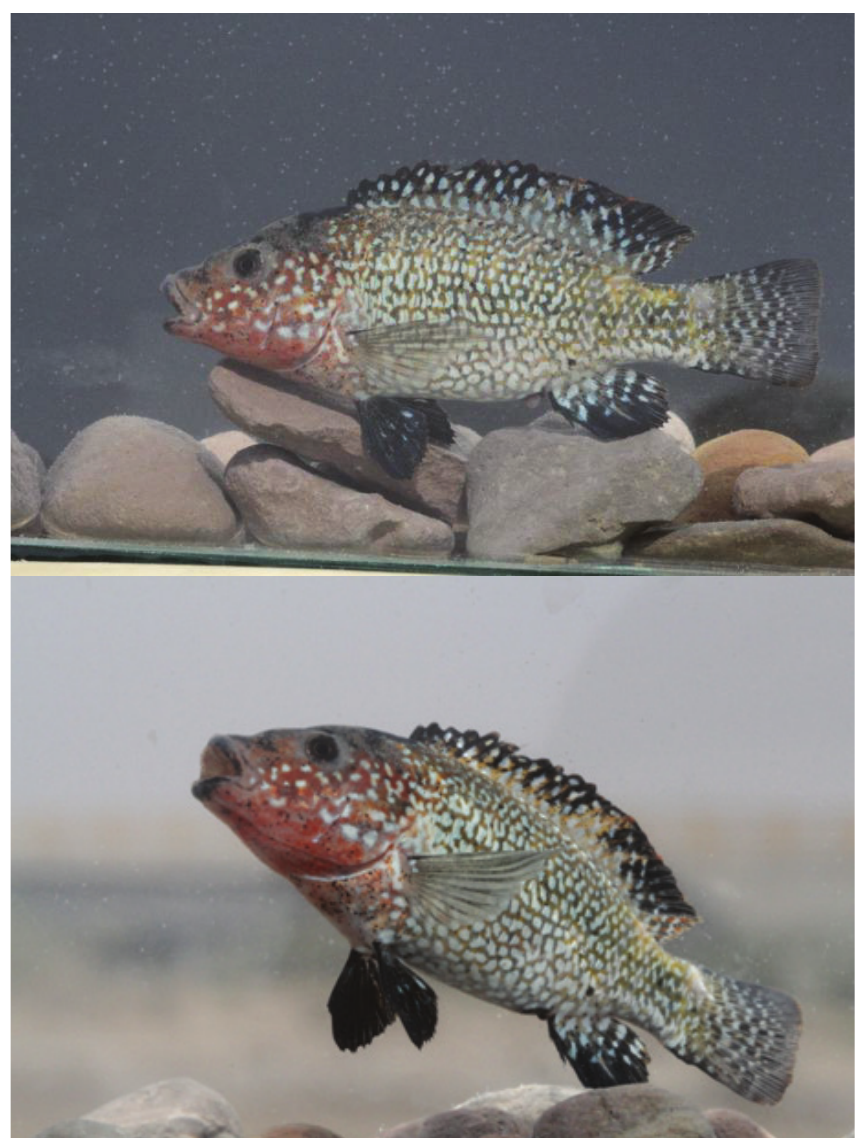
Figure 3. Iranocichla persa , ZM-CBSU-IP66, male, holotype, 89.54 mm SL; Hormuzgan prov.: Shur